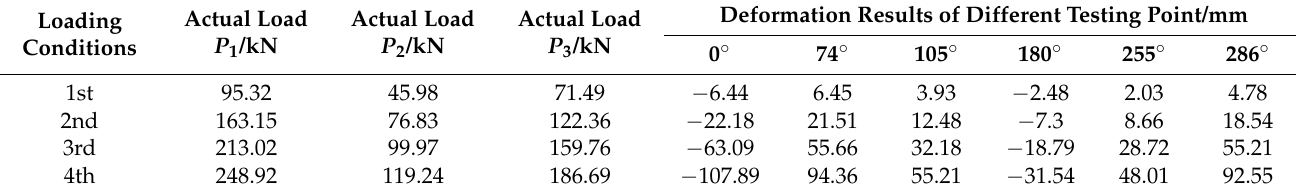
Table 1. Deformations measured in the full-scale